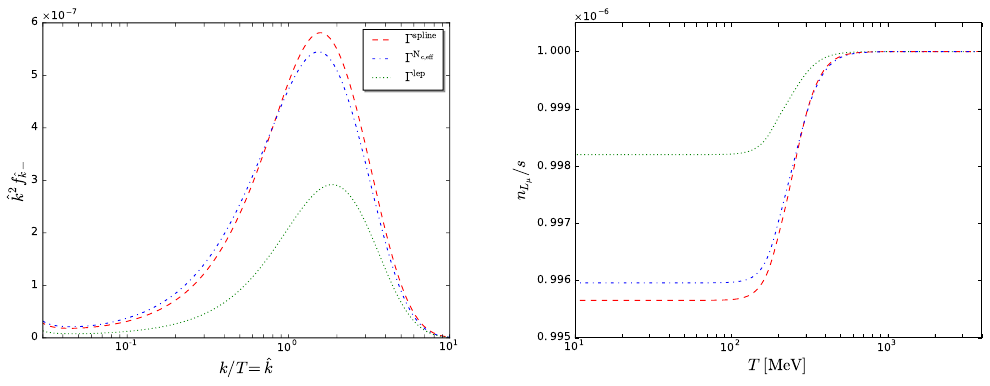
Figure 1 . Solutions to the kinetic equations for M = 7 : 1keV, (cid:18) 2 = 2 : 5 (cid:1) 10 (cid:0) 13 . The di(cid:11)erent (cid:22) curves are obtained with the di(cid:11)erent approximations for (cid:0) (cid:11) . Left: Phase space densities of sterile neutrinos with negative helicity at T = 10 MeV. The fraction of the dark matter energy density is ((cid:10) s = (cid:10) DM ) spline = 5 : 7 (cid:1) 10 (cid:0) 4 , ((cid:10) s = (cid:10) DM ) N = 5 : 3 (cid:1) 10 (cid:0) 4 , ((cid:10) s = (cid:10) DM ) lep = 3 : 2 (cid:1) 10 (cid:0) 4 respectively. c; eff Right: Evolution of the lepton asymmetry.